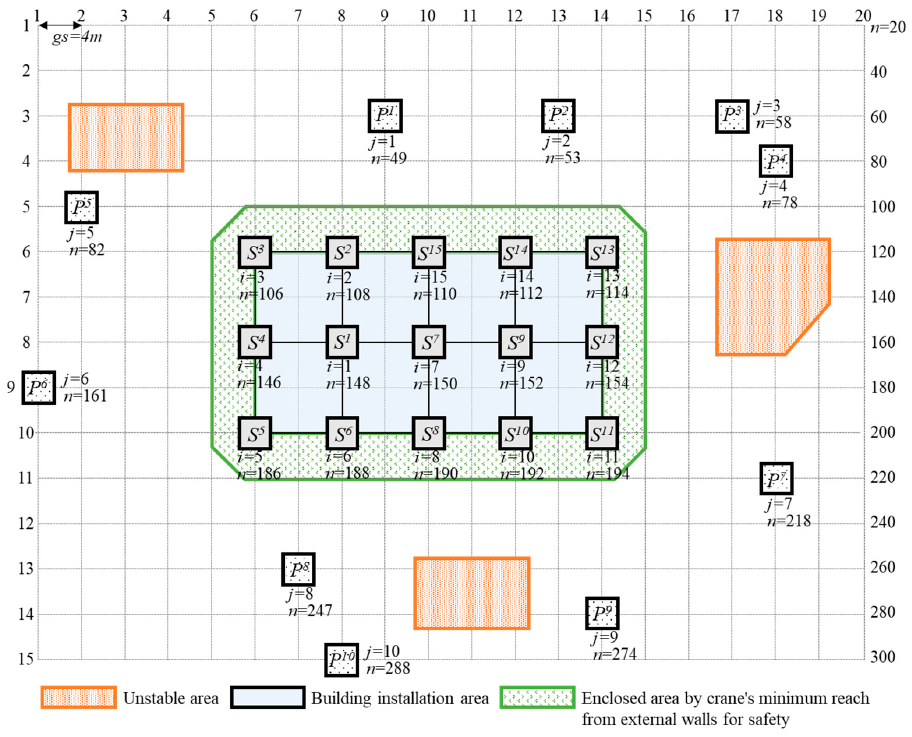
Figure 4. Case study site.